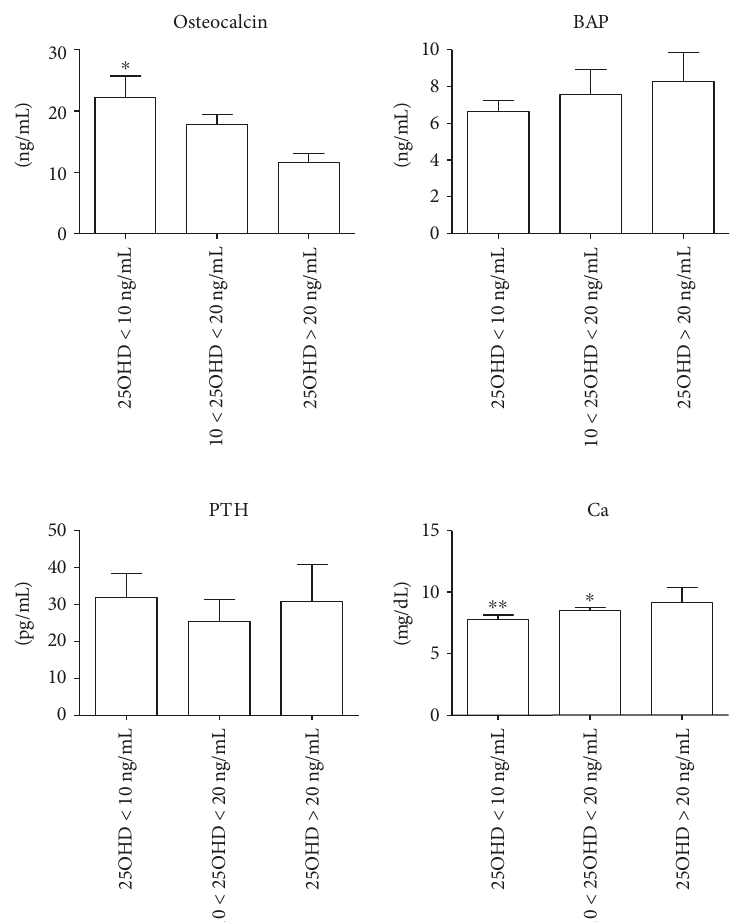
Figure 1: Evaluation of osteocalcin, bone alkaline phosphatase (BAP), parathormone (PTH), and calcium levels in patients with acute aortic dissection (AAD) according to plasma 25OHD concentration. AAD patients were strati fi ed into three groups (severe de fi ciency: 25OHD < 10ng/mL; moderate de fi ciency: 10 – 20ng/mL; mild de fi ciency: > 20 ng/mL) according to plasma 25OHD concentration. ∗ p < 0 05 and ∗∗ p < 0 01 versus 25OHD >